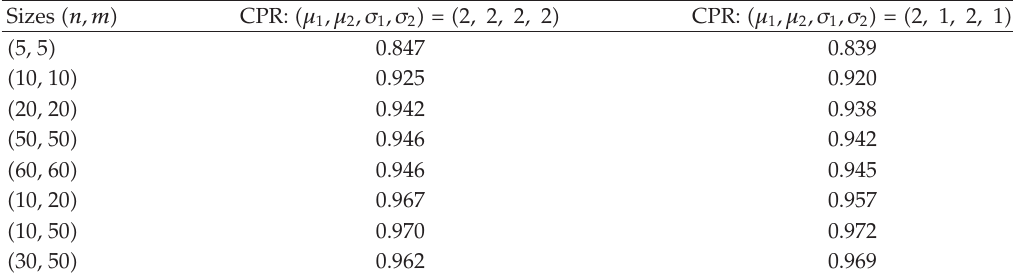
Table 1: The coverage probabilities (cid:2) CPR (cid:3) of the 95% GCI for δ (cid:2) family in (cid:2) 4.8 (cid:3)(cid:3) . Sizes (cid:2) n,m (cid:3)